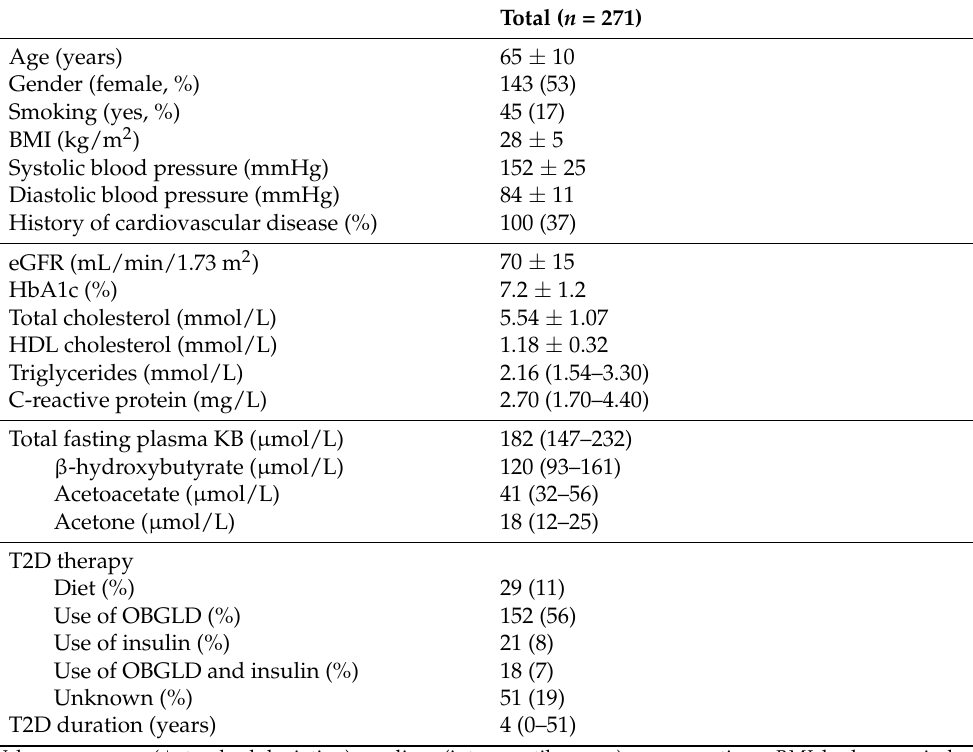
Table 1. Baseline characteristics of participants in